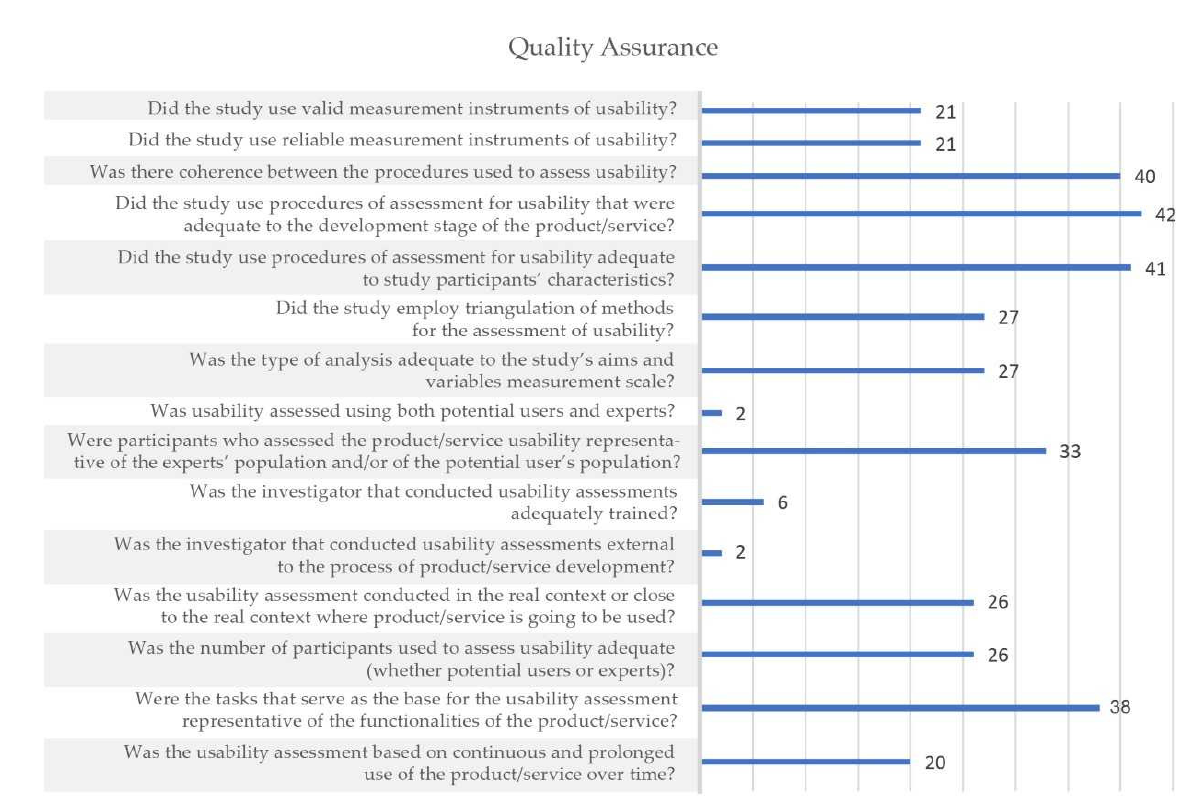
Figure 4. Number of studies that met each item, after consensus was reached between reviewers. Table 4. Level of agreement between the reviewers for each item of CAUSS.